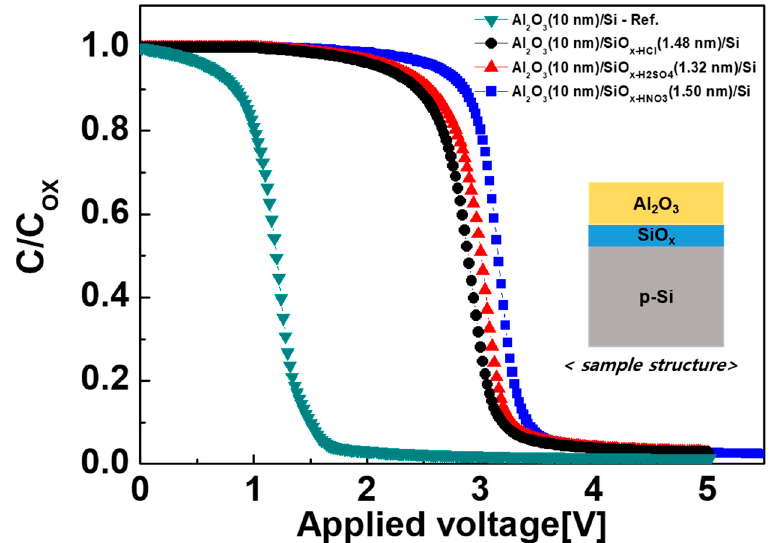
Figure 7. Capacitance–voltage curves at 1 MHz of Al 2 O 3 / SiO x-acidic / Si structures and Al 2 O 3 / Si reference sample for calculating the fixed charge density ( Q f ) and interface trap density ( D it ).